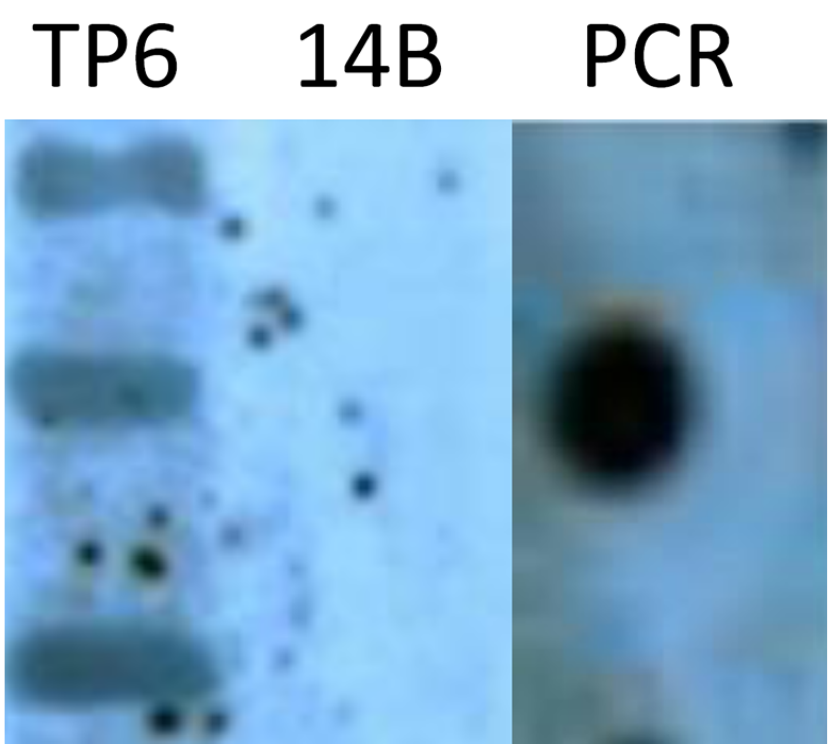
Figure 7 ‒ Southern analysis of gDNA digested with Eco RI and Hind III hybridized with orf165 probe to check copy number of exogenous gene in transgenic male-sterile plant (TP6). Of total gDNA, 10 μg was digested with Eco RI and Hind III, separated in a 0.8% agarose gel, and transferred to a Hybond N+ membrane. The probe was digoxygenin (DIG-11-dUTP)-labeled 400-bp orf165. Southern blotting was performed using the PCR DIG Probe Synthesis Kit and DIG Luminescent Detection Kit according to the manufacturer’s instructions. The orf165 showed three copies in TP6. ML-14B (a maintainer line of CMS 14A) was used as negative control and no band occurred in it; the PCR product of orf165 was used as a positive